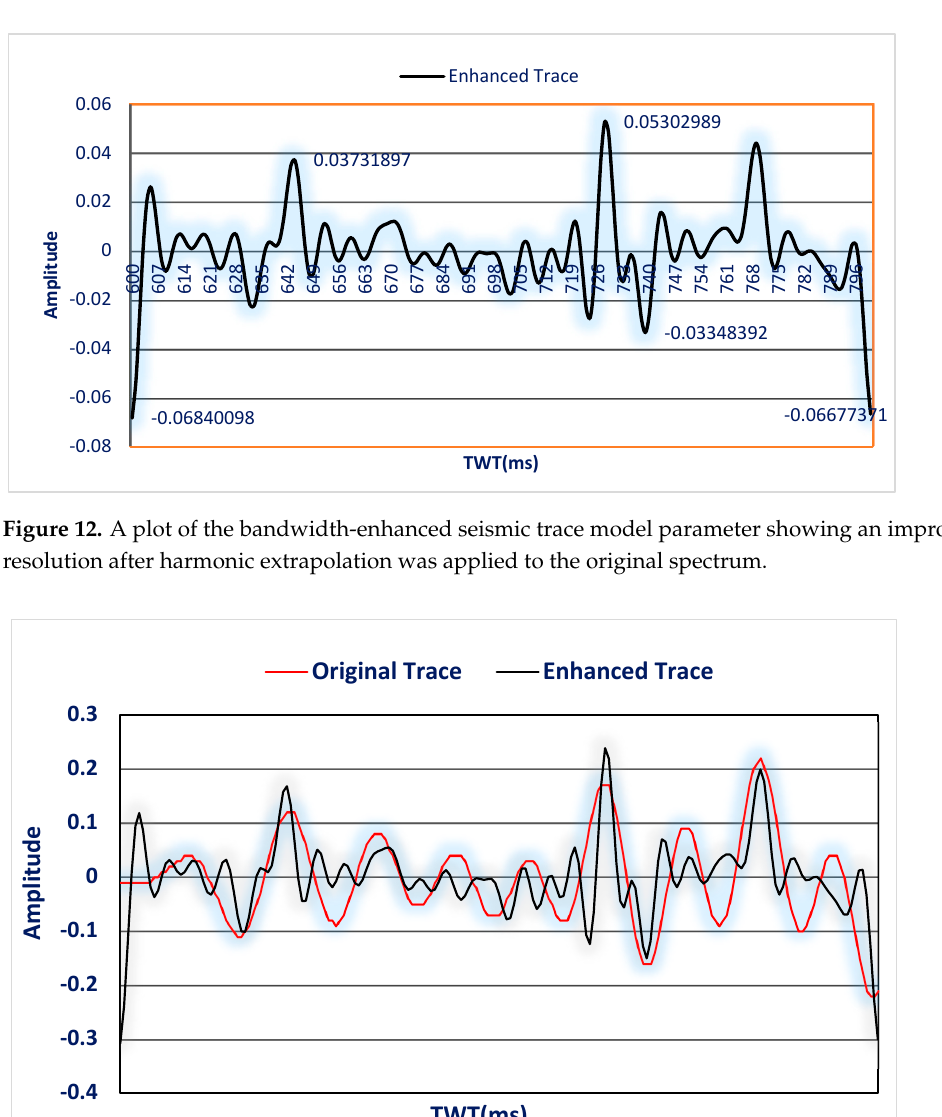
Figure 12. A plot of the bandwidth-enhanced seismic trace model parameter showing an improved resolution after harmonic extrapolation was applied to the original spectrum.